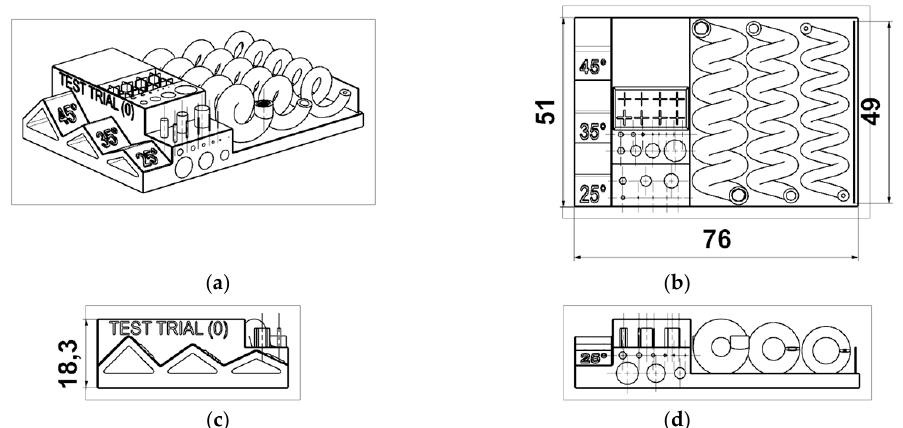
Figure 5. Nominal CAD drawings with reference dimensions. ( a ) isometric view, ( b ) top view, ( c ) left side view, ( d ) front view.